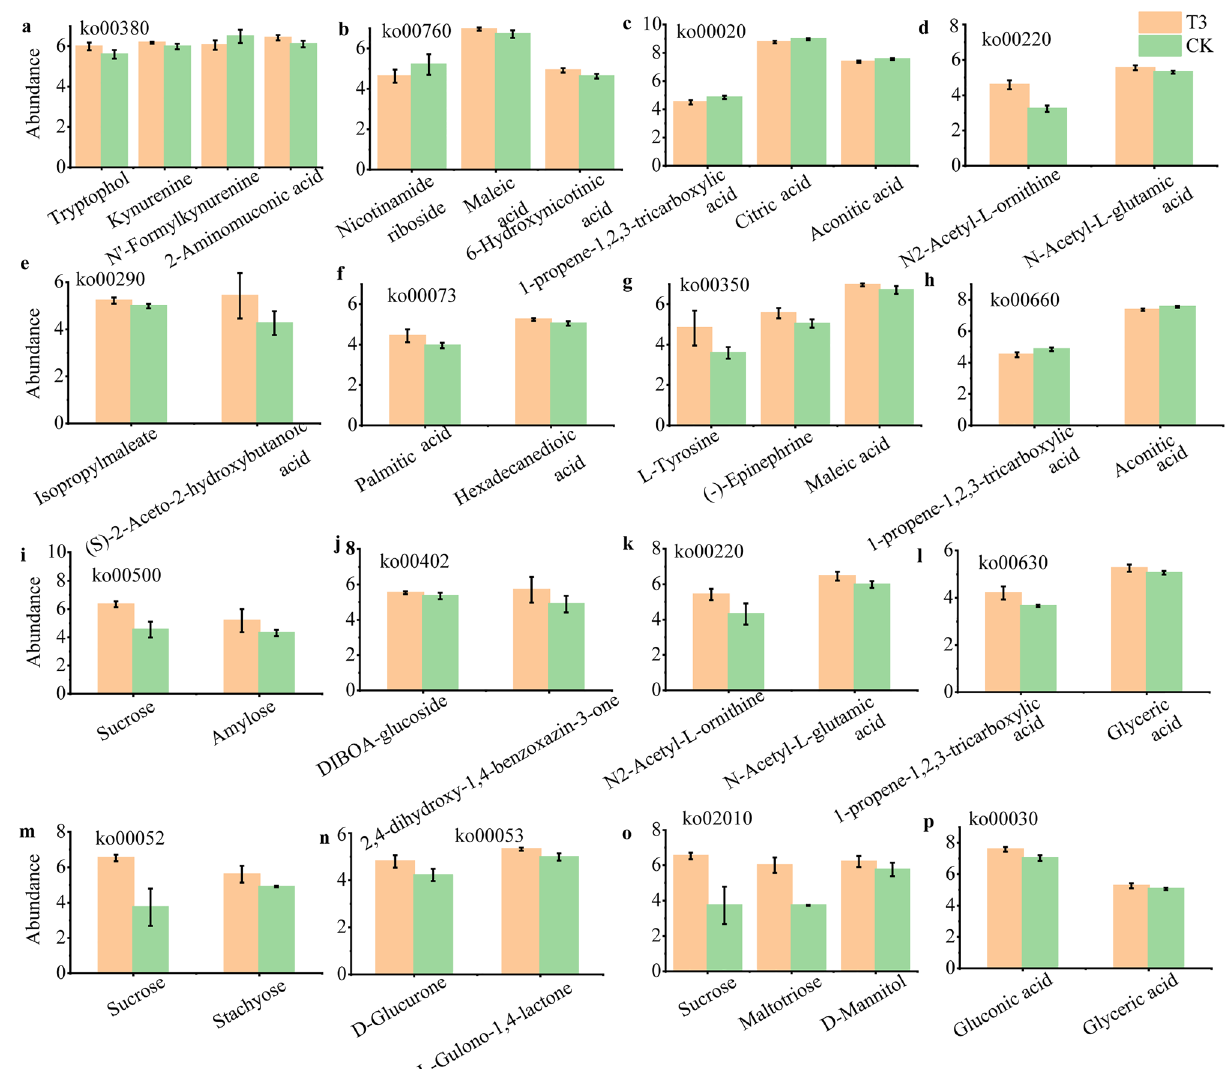
Figure 7. Analysis of differentially abundant metabolites in the significantly enriched KEGG pathway. ( a – i ) T3Aug3 vs. CKAug3. ( j – p ) T3End vs. CKEnd. T3Aug3 (samples from theT3 treatment on August 3rd), CKAug3 (samples from the CK treatment on August 3rd), T3End (samples from the T3 treatment on September 2nd) and CKEnd (samples from the CK treatment on September 2nd). All differences in the figures are significant ( P < 0.05), and the vertical coordinates are mass spectral intensity values (mass spectral intensity after data